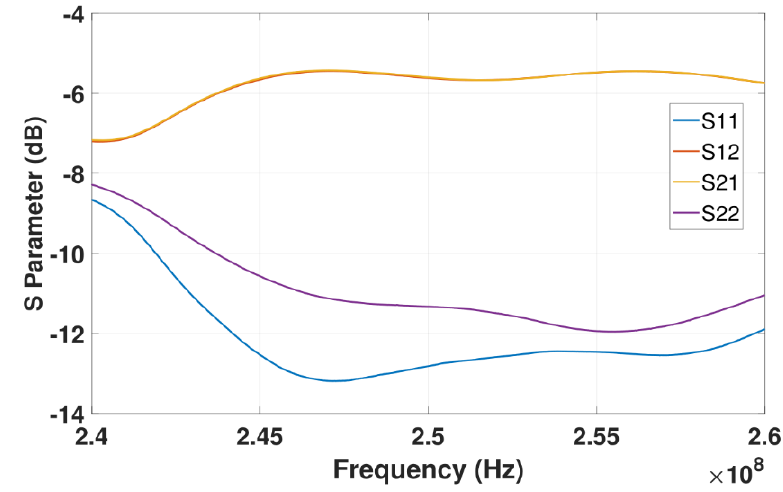
Figure 7. Bow − tie antennas’ S − parameters. Figure 7. Bow−tie antennas’ S −parameters.